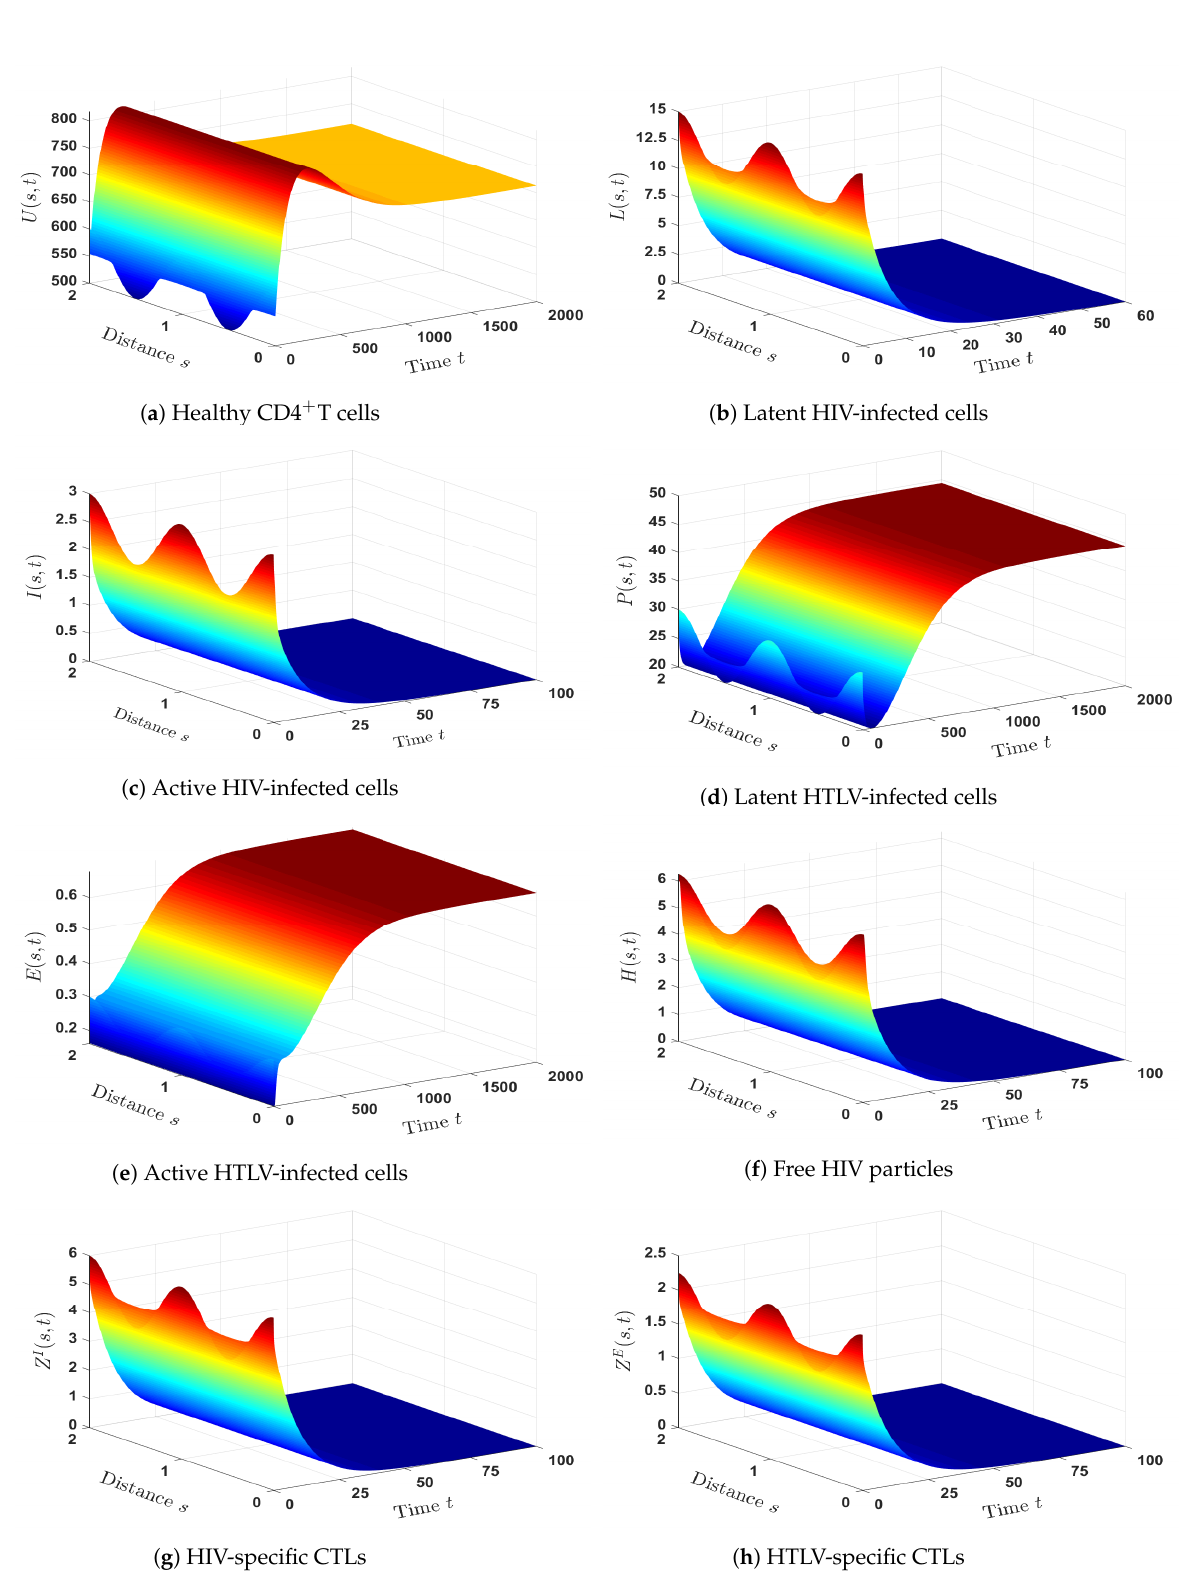
Figure 3. The solution behavior of Model (1) with the initial conditions (26) and boundary condi- tions (27). Taking ω 1 = 0.0001, ω 2 = 0.00005, ω 3 = 0.00007, ω 4 = 0.006, υ 1 = 0.001, υ 2 = 0.05, we have R 2 = 1.4 > 1, R 1 / R 2 = 0.58 < 1, R 4 = 0.64 < 1, and the equilibrium ˇ S 2 = ( 713.33,0,0,44.47,0.67,0,0,0 ) is asymptotically